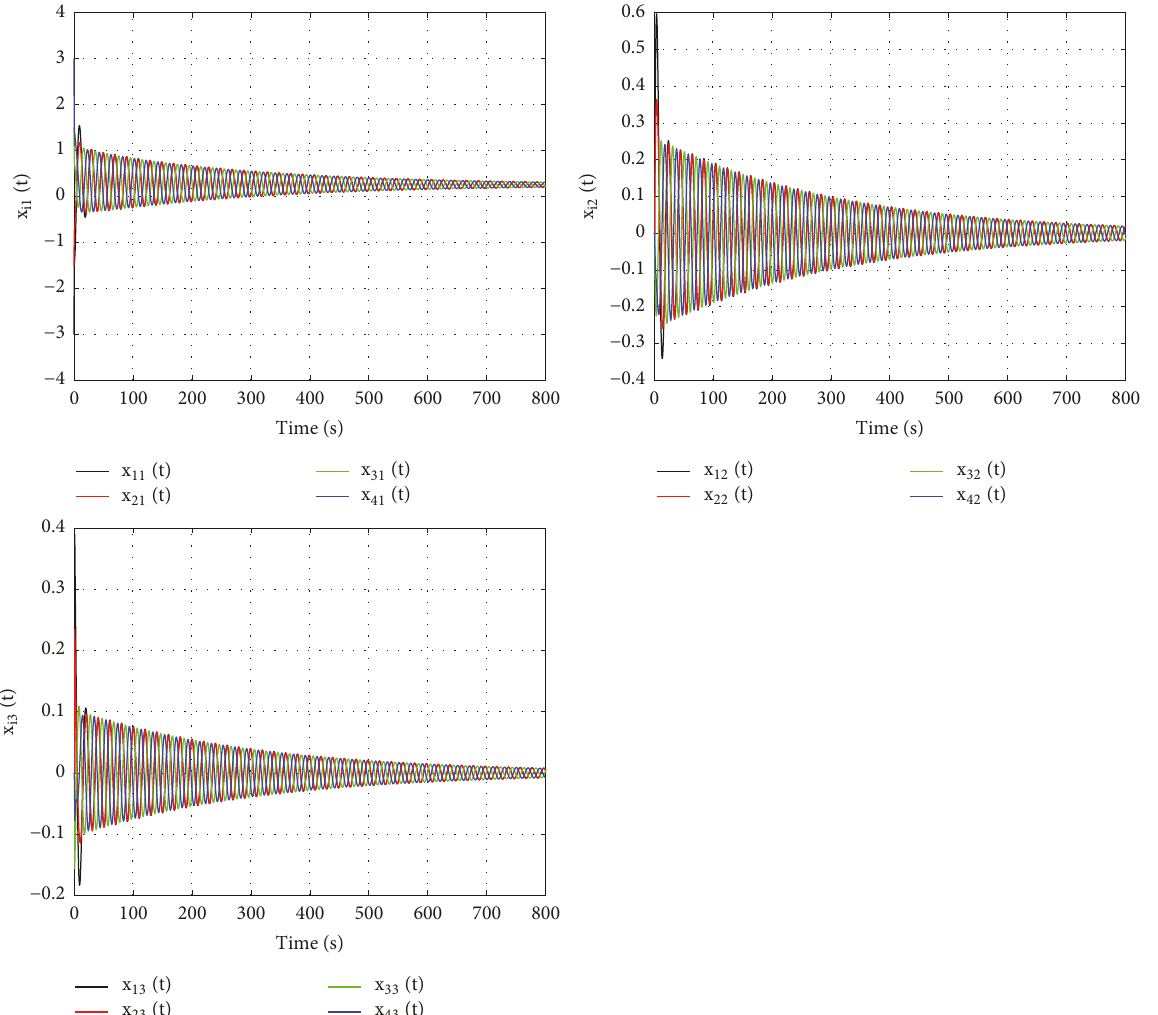
Figure 11: The trajectories of all agents’ states in the FOMAS with triple integral and asymmetric time-delays when all 𝜏 𝑚 < 𝜏 in Example 5.